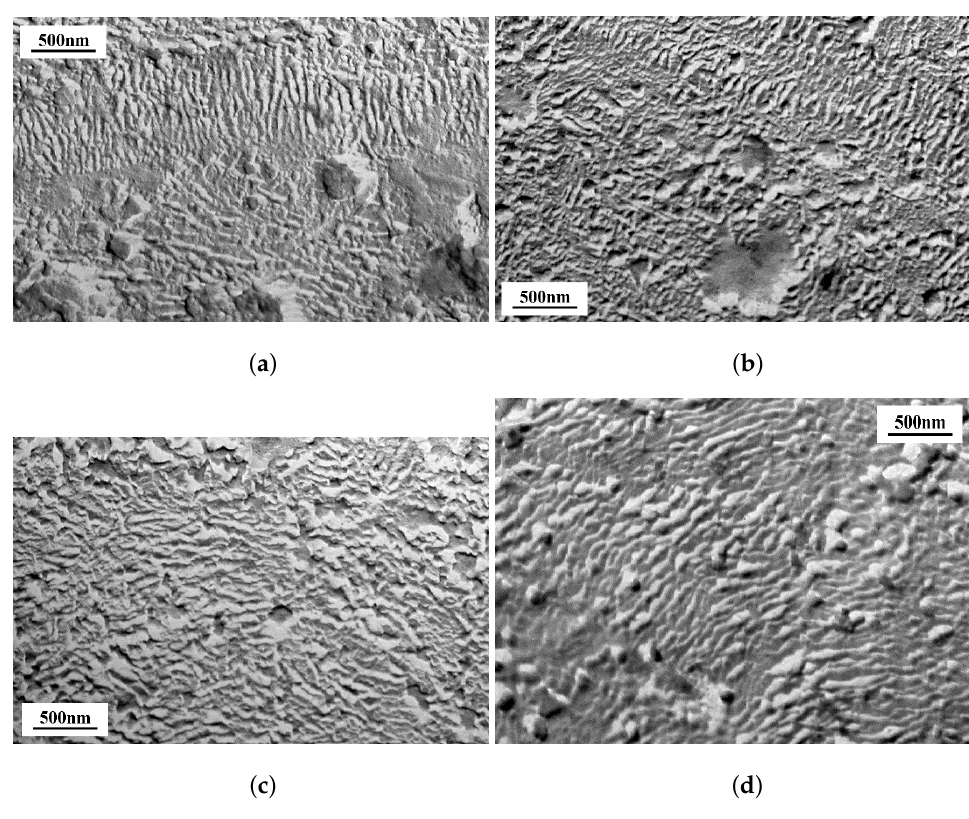
Figure 6. Electron microphotographs of HDPE: HDPE 277-73 ( a ); HE3490-IM ( b ); CRP100 Hostalen ( c ); and Stavrolen PE4PPP-25B ( d